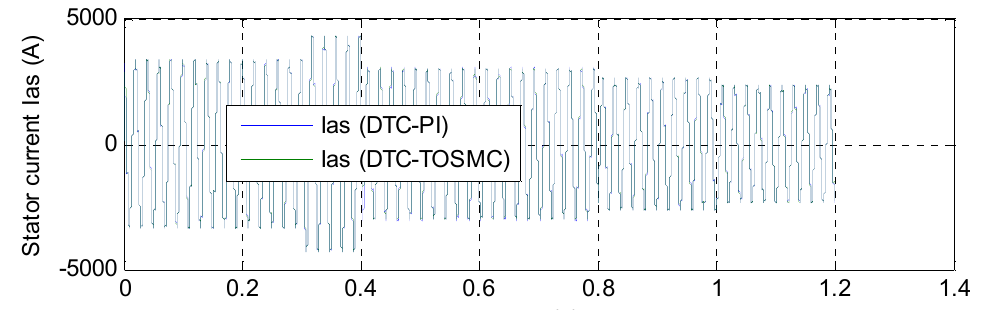
Figure 10. Stator current.